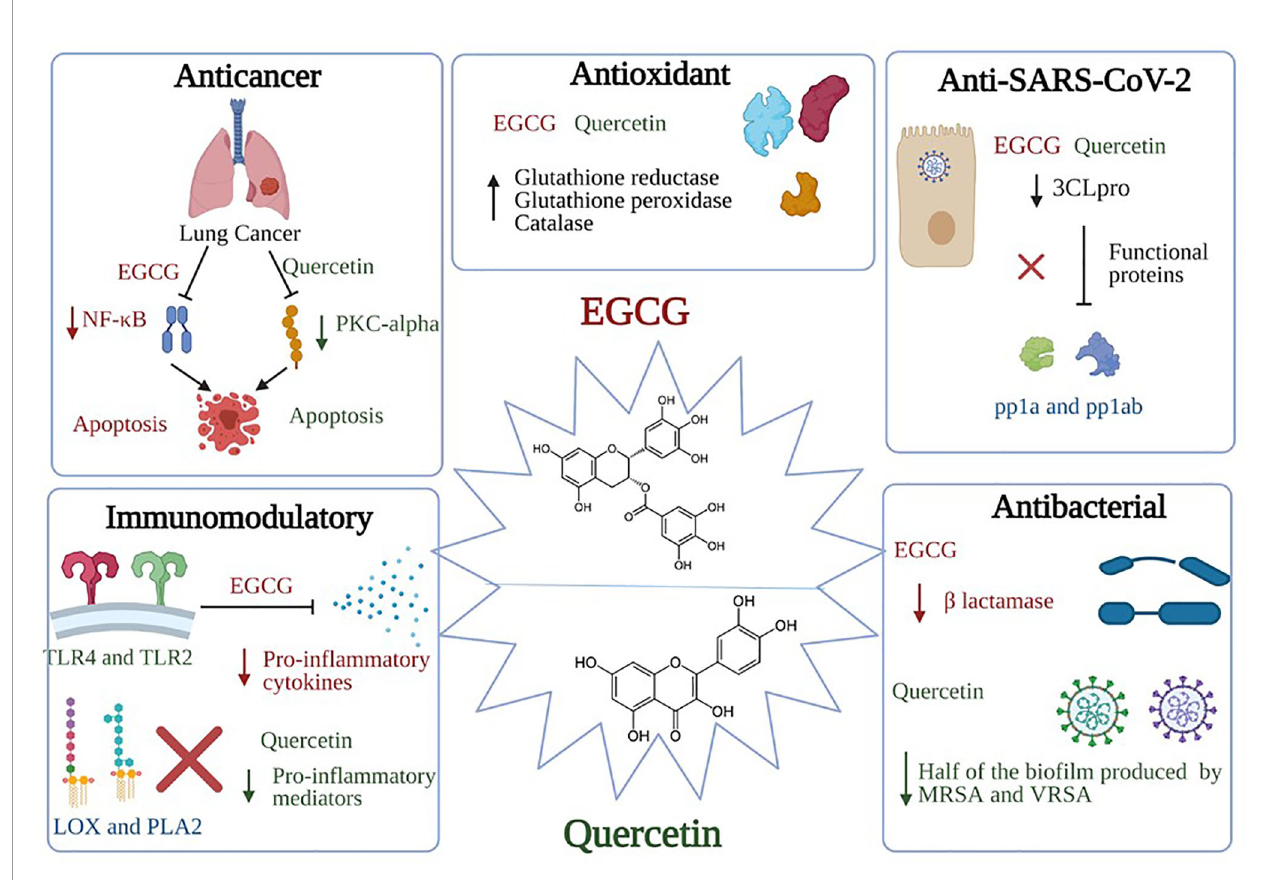
FIGURE 3 | Signi fi cant pharmacological activities of EGCG and quercetin. Green tea, with its main two active constituents EGCG and quercetin, contributes to a wide range of medicinal activities such as antioxidant, immunomodulatory, anticancer, antiviral, and antibacterial actions. EGCG anticancer activity is produced by suppressing the NF- k B signaling in A549 and H1299 cells; activation of apoptotic cascades are also initiated, resulting in a marked hindering of cellular proliferation. On the other hand, quercetin inhibits the protein kinase C (PKC- a ), a survival signaling protein, repressing several cancer hallmarks. Concerning the immunomodulatory actions, EGCG induces TLR4 and TLR2 expression levels, thus depleting the mitogen-activated protein kinase (MAPK) pathway and repression of pro-in fl ammatory cytokines release. As for the quercetin, it inhibits pro-in fl ammatory mediators such as Lipoxygenase and Phospholipase A2. Besides, both constituents share the same antiviral mechanism against SARS-CoV-2, which is binding to “ 3Cl pro ” or “ M pro ” , preventing the processing of viral proteins pp1a and pp1ab into functional proteins in the host cells. Bona fi da, the antioxidant effects of both EGCG and quercetin are mediated through scavenging and neutralizing the free radicals and boosting the enzymes that are responsible for detoxi fi cation such as glutathione reductase, glutathione peroxidase, and catalase. Finally, quercetin showed potential antibacterial activity through inhibiting half of the bio fi lm production by methicillin-resistant S. aureus (MRSA) and vancomycin-resistant S. aureus (VRSA). Similarly, EGCG showed